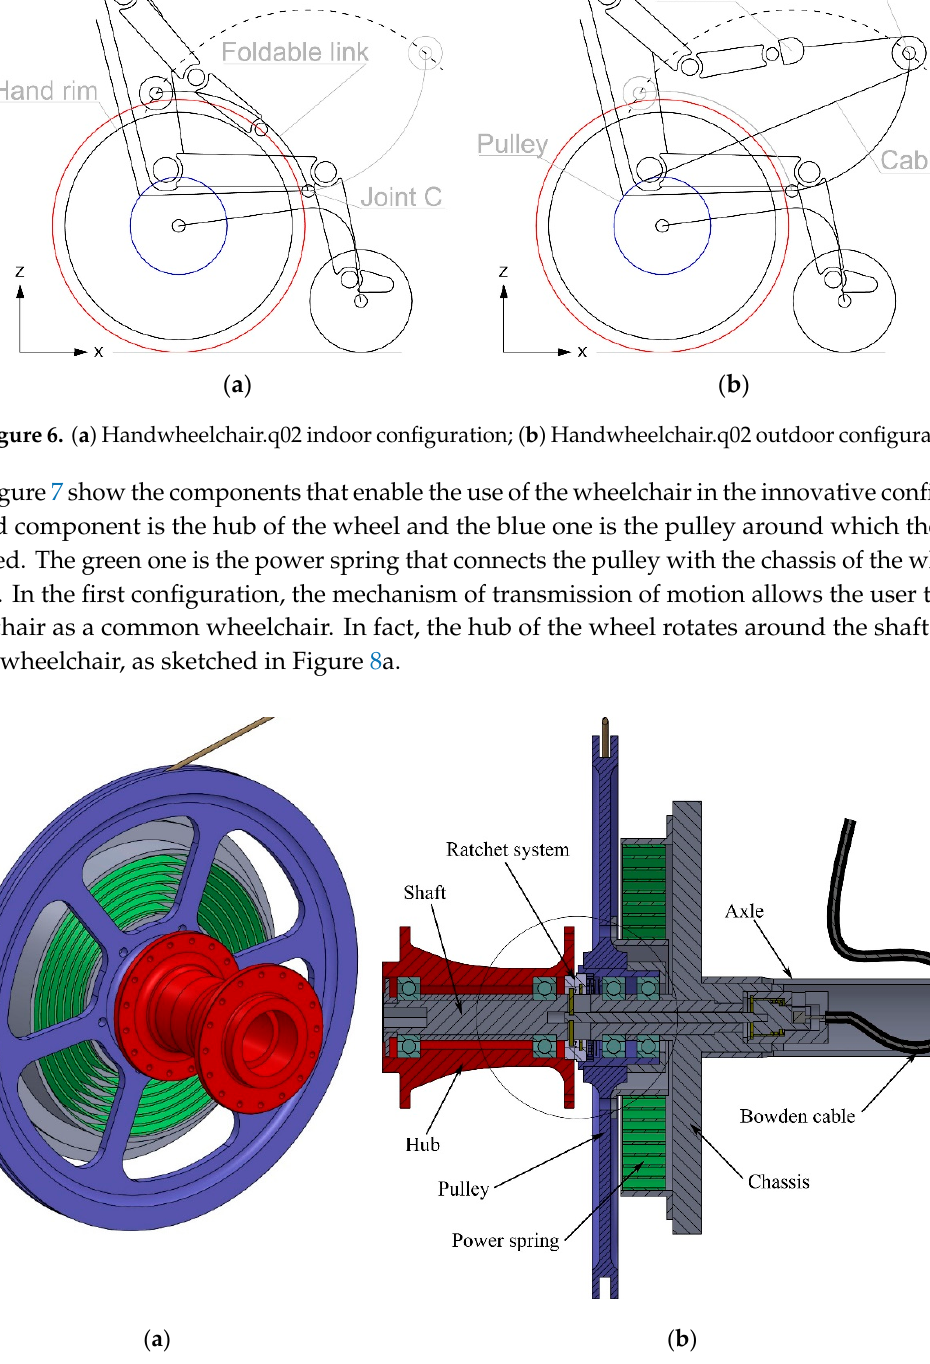
Figure 7. ( a ) Components of the innovative system of propulsion; ( b ) Section of the mechanism.